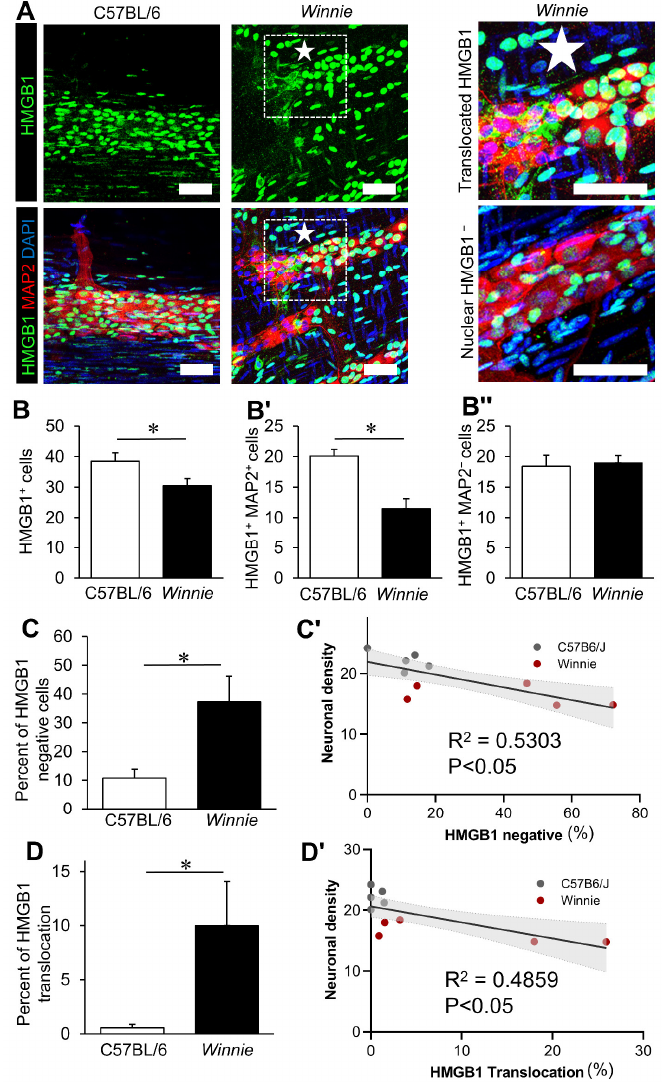
Figure 2. Neuronal translocation of HMGB1 associates with enteric neuropathy in Winnie mice. ( A ) HMGB1 in neurons within the myenteric ganglia was observed by immunofluorescence of HMGB1, the neuronal marker MAP-2 and the nuclear stain DAPI in fresh fixed LMMP wholemount preparations from the distal colon of C57BL/6 and Winnie mice. Magnified images demonstrate the unique staining patterns of HMGB1 observed in Winnie mice, including the translocation of HMGB1 to the neuronal cytoplasm and loss of nuclear HMGB1 in the neurons but not enteric glia. (scale bar = 50 µm). ( B – B’’ ) Quantification of the total number of cells ( B ), neurons ( B’ ) and non-neuronal cells ( B’’ ) with nuclear HMGB1 in the myenteric plexus expressed as cells per ganglionated area. ( C ) Percentage of neurons without HMGB1 in the nucleus. ( C’ ) Linear correlation between neuronal density and the percentage of neurons without nuclear HMGB1 expression. ( D ) Percentage of neurons with HMGB1 translocated to the cytoplasm. ( D’ ) Linear correlation between neuronal density and the percentage of neurons with cytoplasmic HMGB1 translocation. * p < 0.05; C57BL/6: n = 5 animals, Winnie : n = 7 animals.